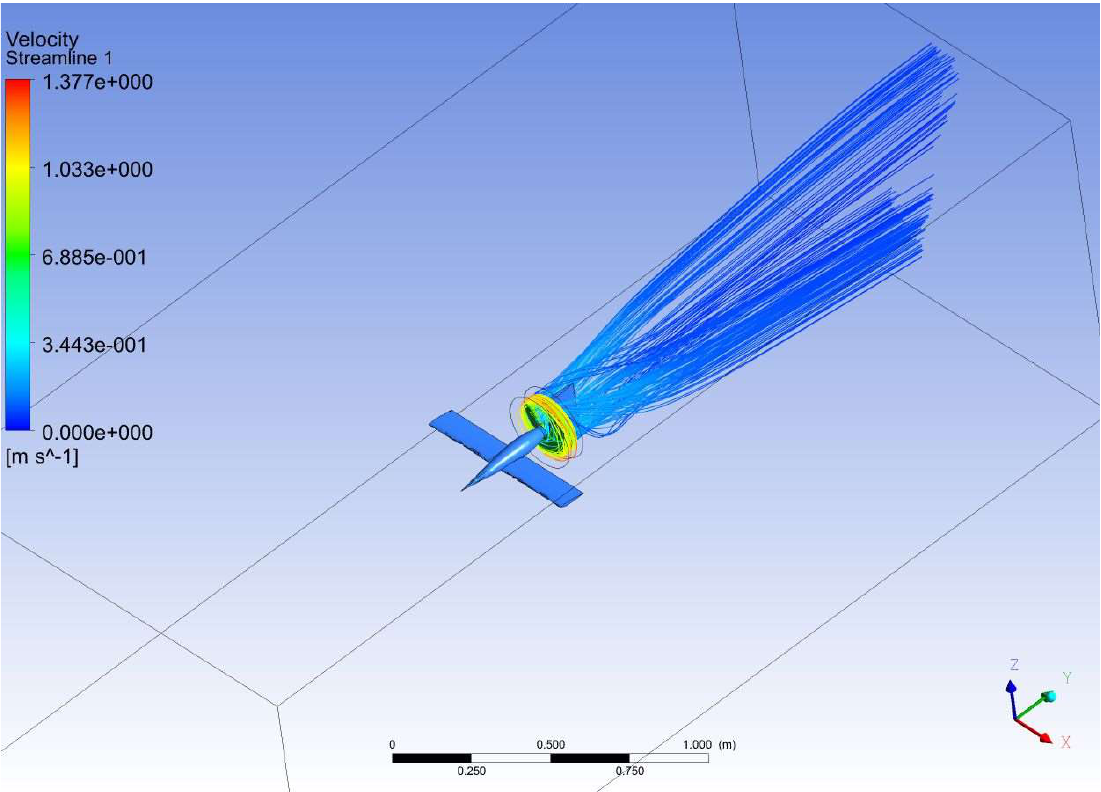
Figure 42. Aerodynamic velocity representations through streamline on rotating propeller. The comprehensive outcomes of induced drag on both models are listed in Table 4. Table 4. Comparative report of Drag.